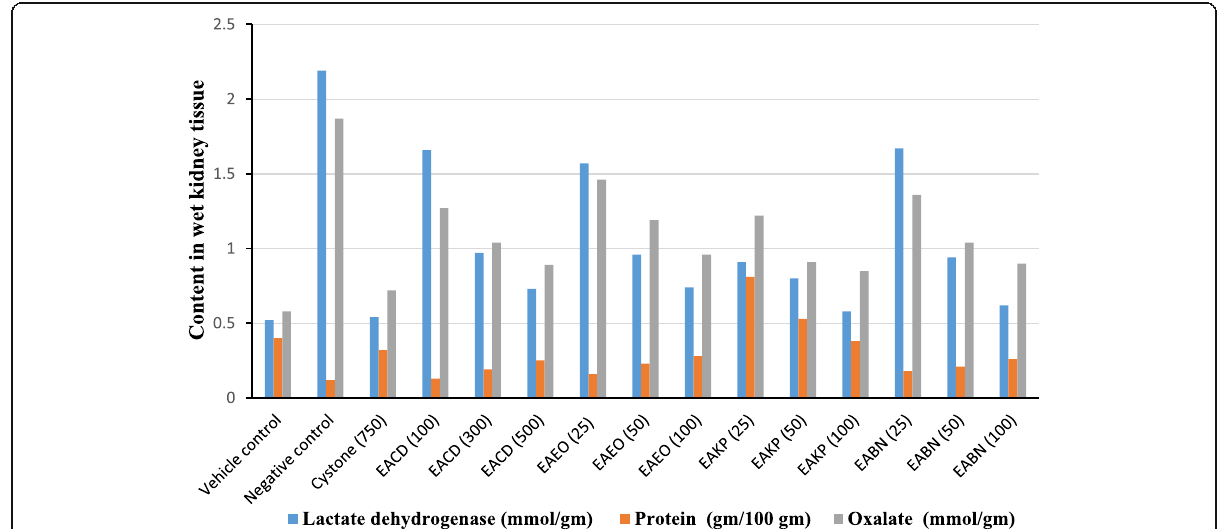
Fig. 1 Kidney tissue parameters of glyoxalate induced nephrolithiatic mice treated with ethyl acetate fraction of C. dactylon , E. officinalis , K. pinnata , and B. nutans . EACD ethyl acetate fraction of C. dactylon , EAEO ethyl acetate fraction of E. Officinalis , EAKP ethyl acetate fraction of K. pinnata , EABN ethyl acetate fraction of B.